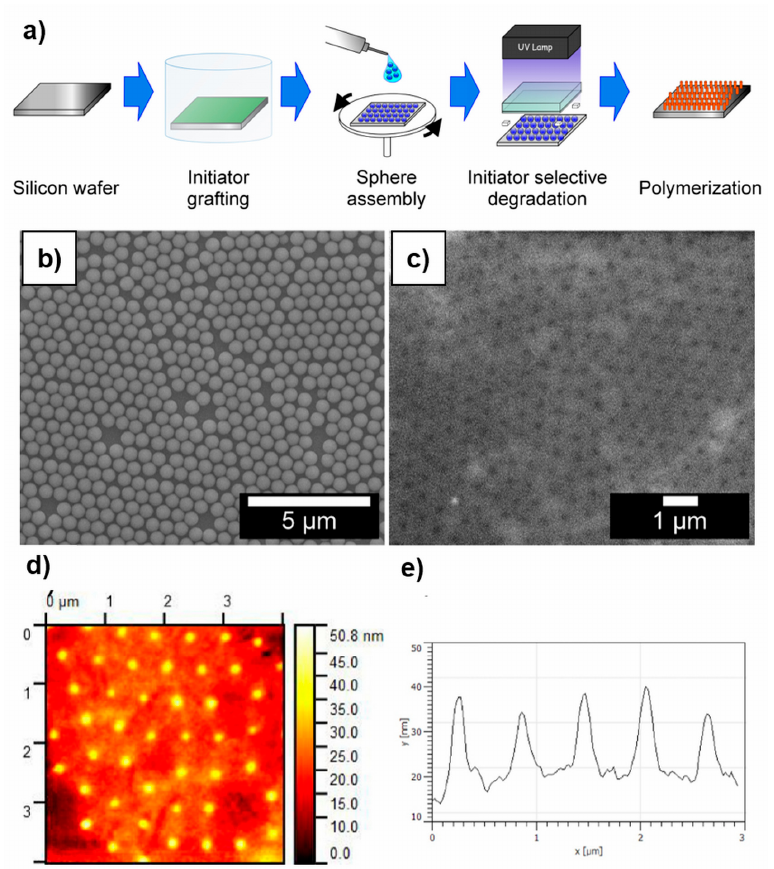
Figure 6. Patterned polymer brushes obtained by remote photocatalytic colloidal lithography: ( a ) schematic representation of the process; ( b , c ) Scanning electron microscopy (SEM) images of the self-assembled colloidal mask and of the resulting polymer brushes pattern, respectively; ( d , e ) AFM and profile images of the polymer brushes pattern obtained. Reproduced with permission from [42], Wiley, 2016.